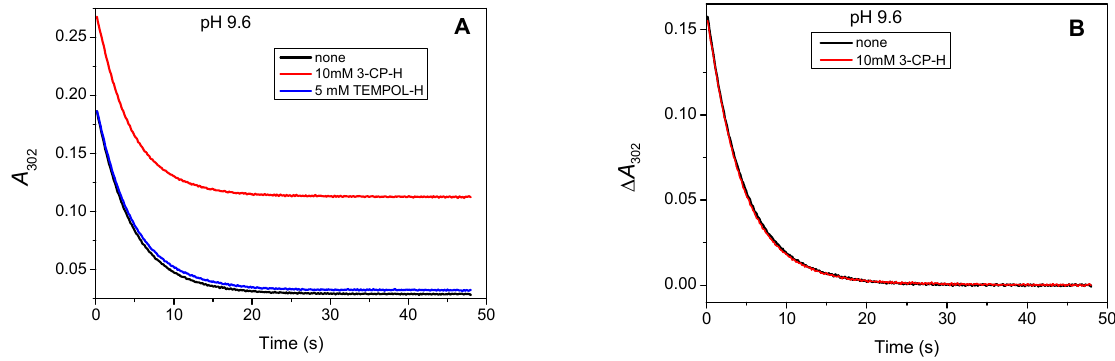
Figure 2. Reaction of ONOO − with RNO-H. ( A ) Decay of 120 µ M ONOO − monitored at 302 nm in the absence (black curve) and in the presence of 10 mM 3-CP-H (red curve) or 5 mM TEMPOL-H (blue curve) at pH 9.6; ( B ) absorbance changes ( ∆ A 302 ) in the absence and presence of 10 mM 3-CP-H at pH 9.6. Solutions contained 0.1 M borate buffer and 100 µ M DTPA.